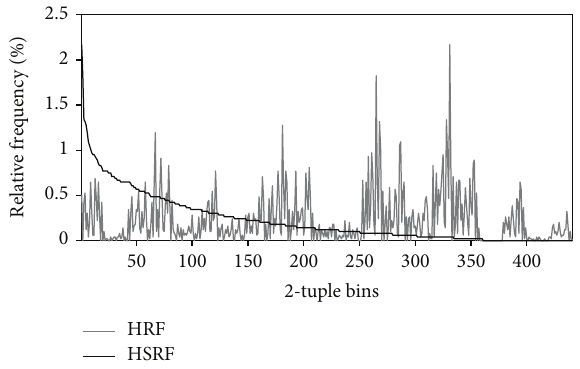
Figure 1: HRF and HSRF of the human chromosome 1. Figure 2: HRF and HSRF of the PCLO HUMAN Q9Y6V0-6 protein.